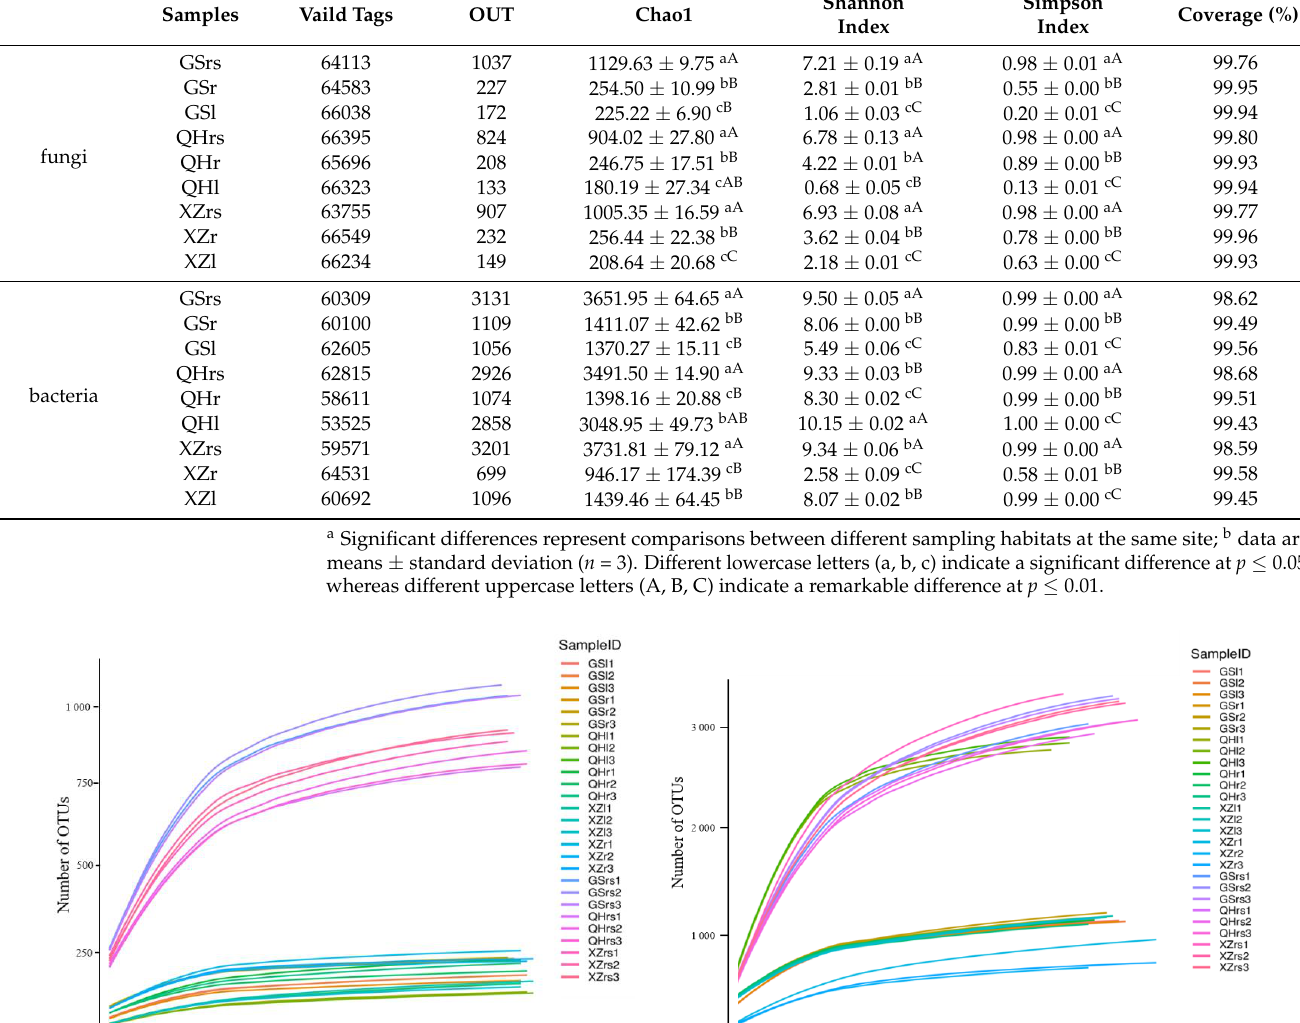
99.45 a Significant differences represent comparisons between different sampling habitats at the same site; b data are means ± standard deviation ( n = 3). Different lowercase letters (a, b, c) indicate a significant difference at p ≤ 0.05, whereas different uppercase letters (A, B, C) indicate a remarkable difference at p ≤ 0.01. 3.4. The Degree of Microbial Species (OTU) Overlap and Dissimilarity in Microbial Community Composition within and between Habitats In order to identify significant differences and the correlation in fungal and bacterial community composition at different habitats (rhizosphere soil, leaves and roots) and lo- cations, the Kruskal – Wallis one-way analysis of variance (one-way ANOVA) was used for ranking, then all pairwise multiple comparison procedures (Tukey test), and Spear- man rank-order correlation was used to assess the correlation. There was no significant